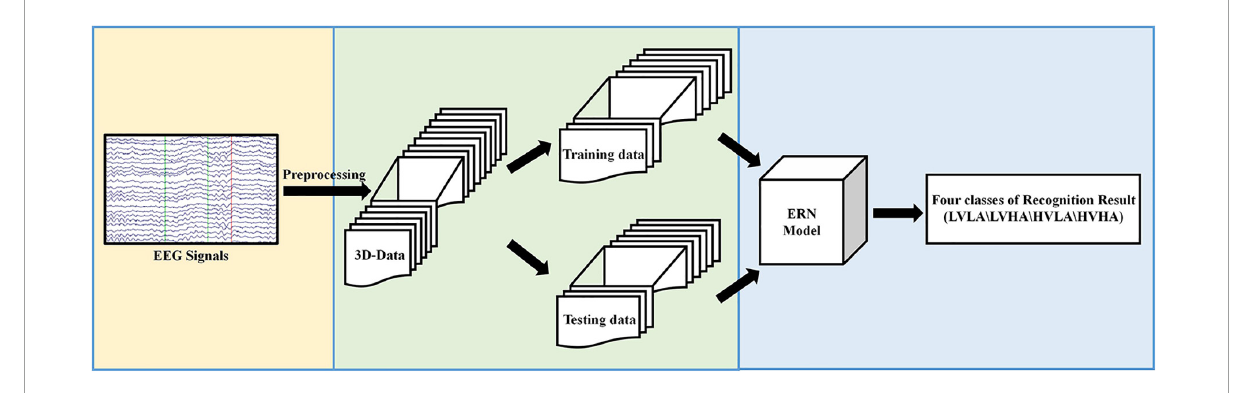
FIGURE1 Overview of the proposed